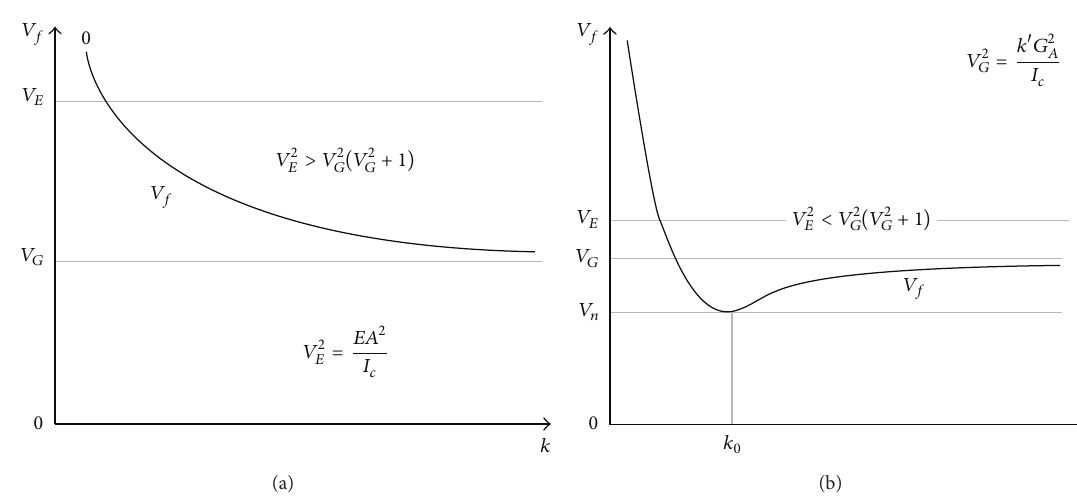
Figure 1: Phase waves velocities 𝑉 𝑓 versus wave number dependent on the beam parameters (inequality (3)).